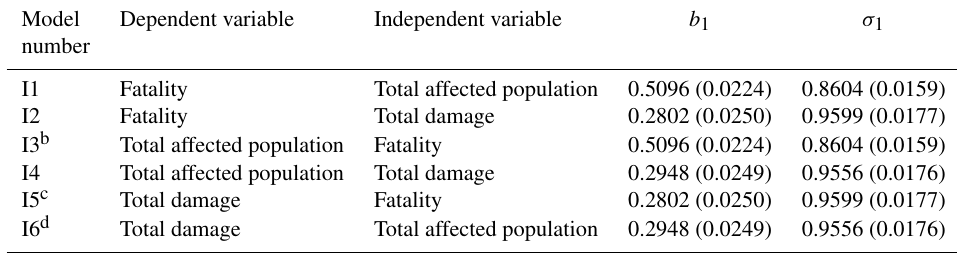
Table A1. Statistics of parameters of six simple linear regression models for filling in missing values of impact variables a .